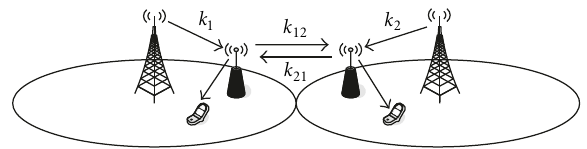
Figure 2: Two-BS two-relay system